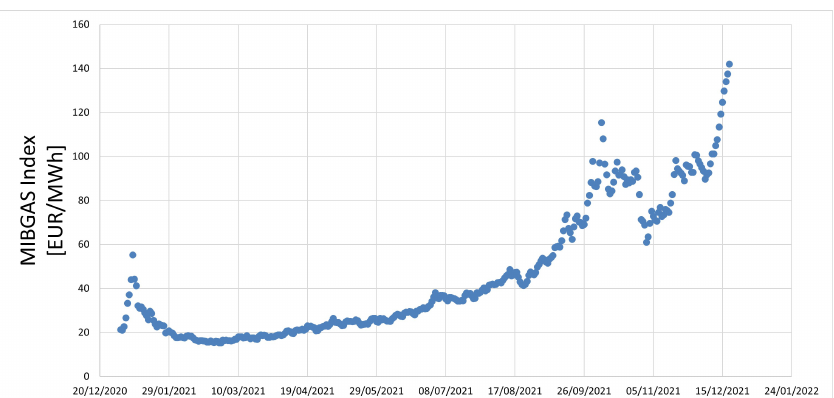
Figure 1. Monthly evolution of the average weighted price of natural gas for 2021